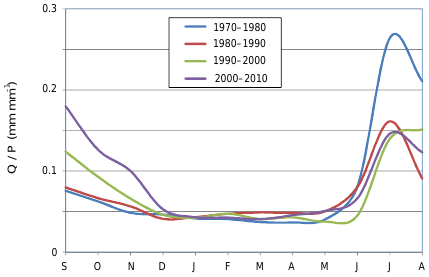
Figure 13. Monthly values of precipitation averaged over six sta-